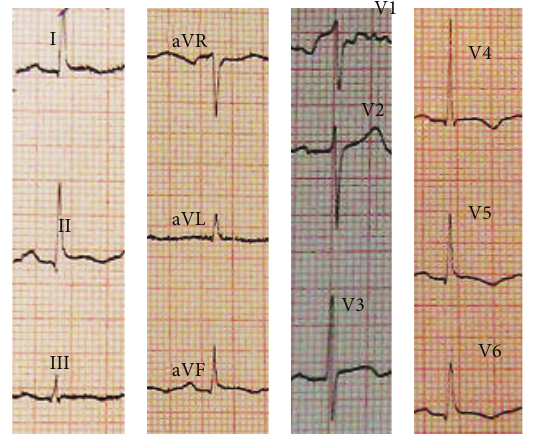
Figure 5: The electrocardiogram at 3rd day of admission revealing “deep” T-wave inversion at leads I, II, III, aVL, aVF, and